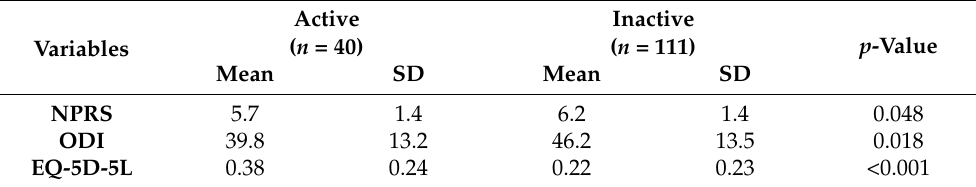
Table 3. Correlation between professional situation and medical assessment